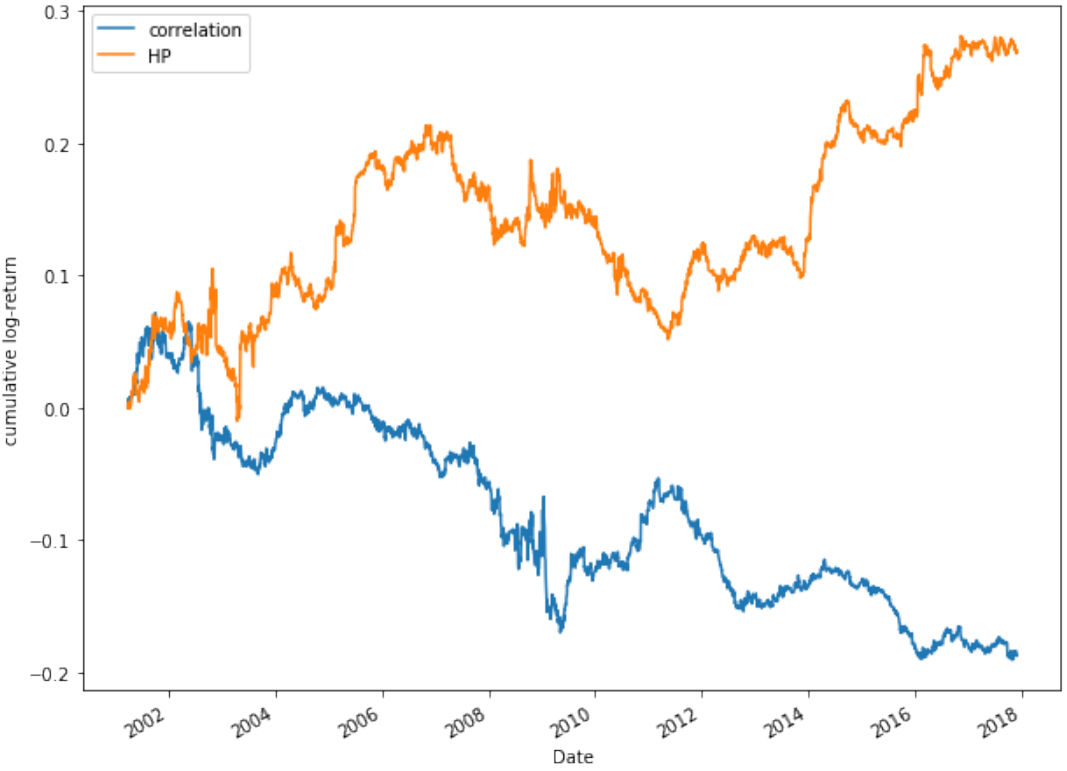
Figure 21. Comparative cumulative log-return of a 5-pair portfolio between HP (HP2 version) and Pearson’s correlation coefficient methods, of Dow Jones securities in the period